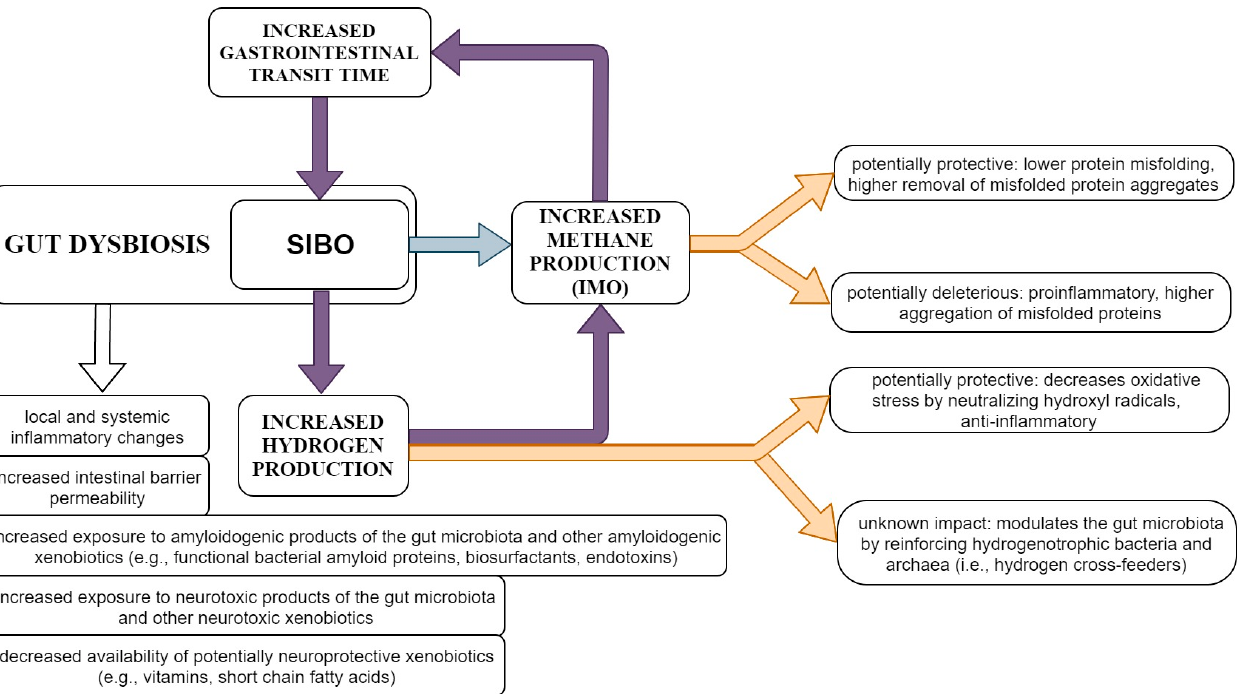
Figure 2. Main mechanisms underlying the relation between SIBO-related H 2 and methane (over)production and the progression of sporadic PD. The figure illustrates the specific mechanisms that may link the intestinal production of H 2 and methane with disease progression in people with sporadic PD and SIBO. General mechanisms related to gut dysbiosis, including SIBO, are also summarized. Depending on the functional characteristics of the SIBO microbiota (as well as particularities of the host) H 2 and methane may have both beneficial and deleterious effects, requiring further investigation. Better understanding of these relations could offer means for personalized interventions and precision medicine in PD.